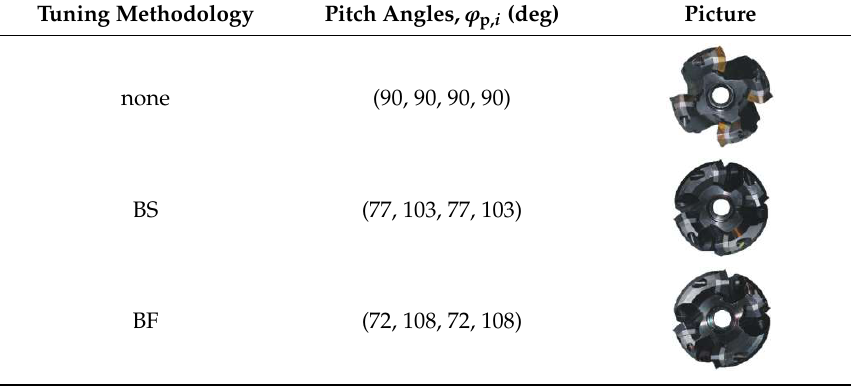
Table 3. Tuned pitch solutions for spindle speed n = 636 rpm according to Figure 5a,b).